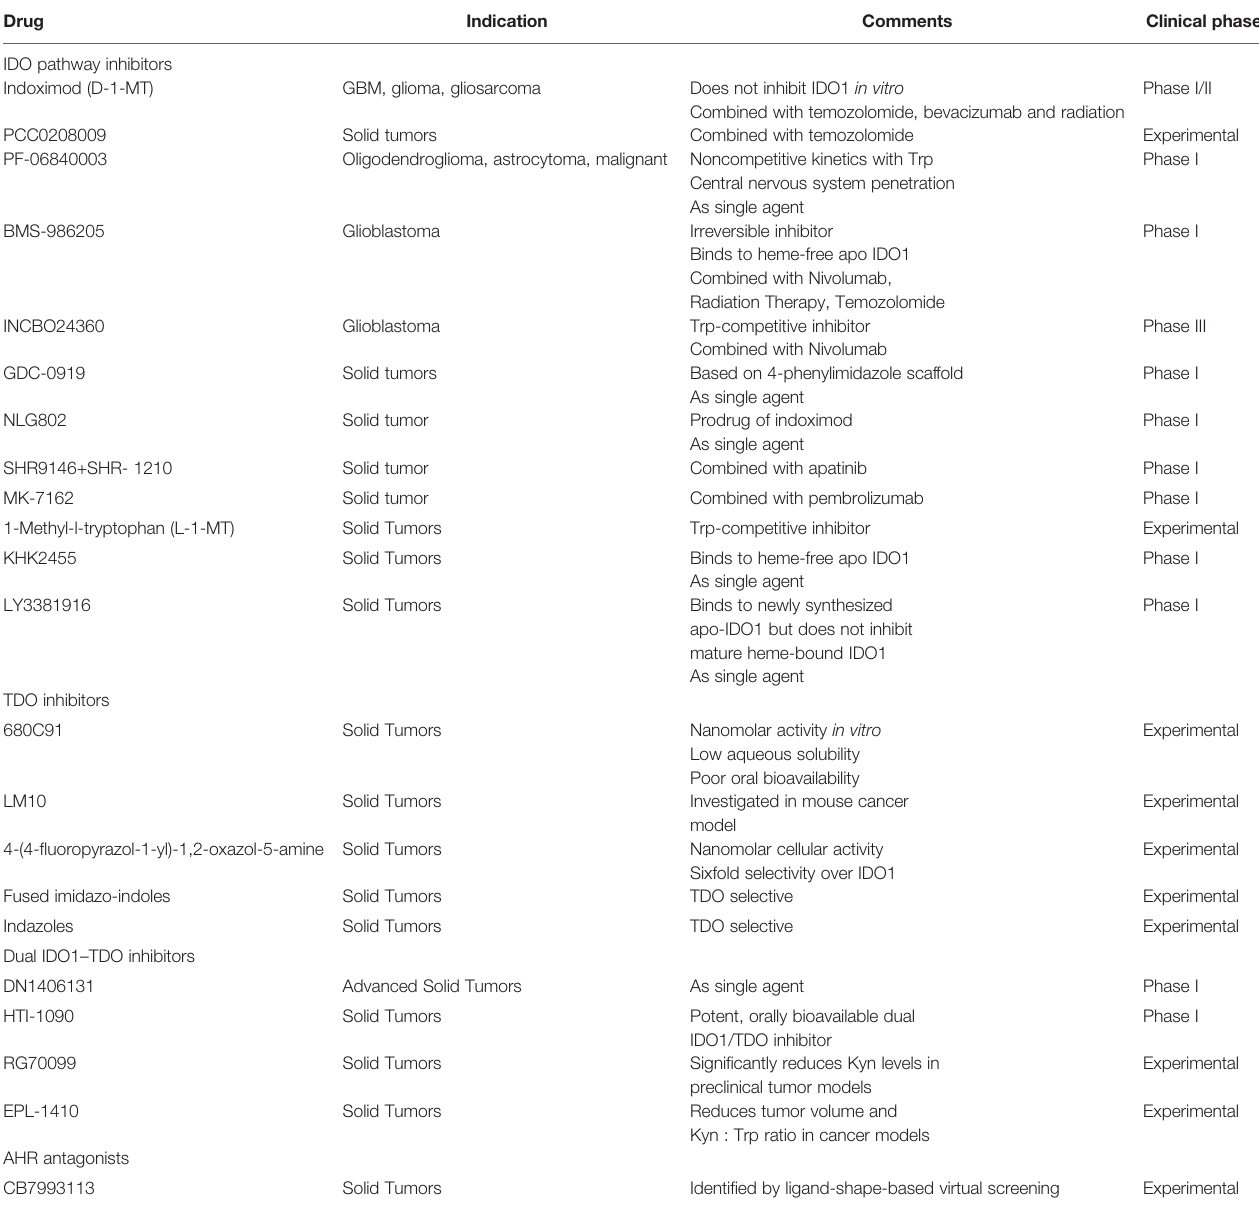
TABLE 1 | Drug research aimed at key targets in the tryptophan metabolic pathway in glioma.